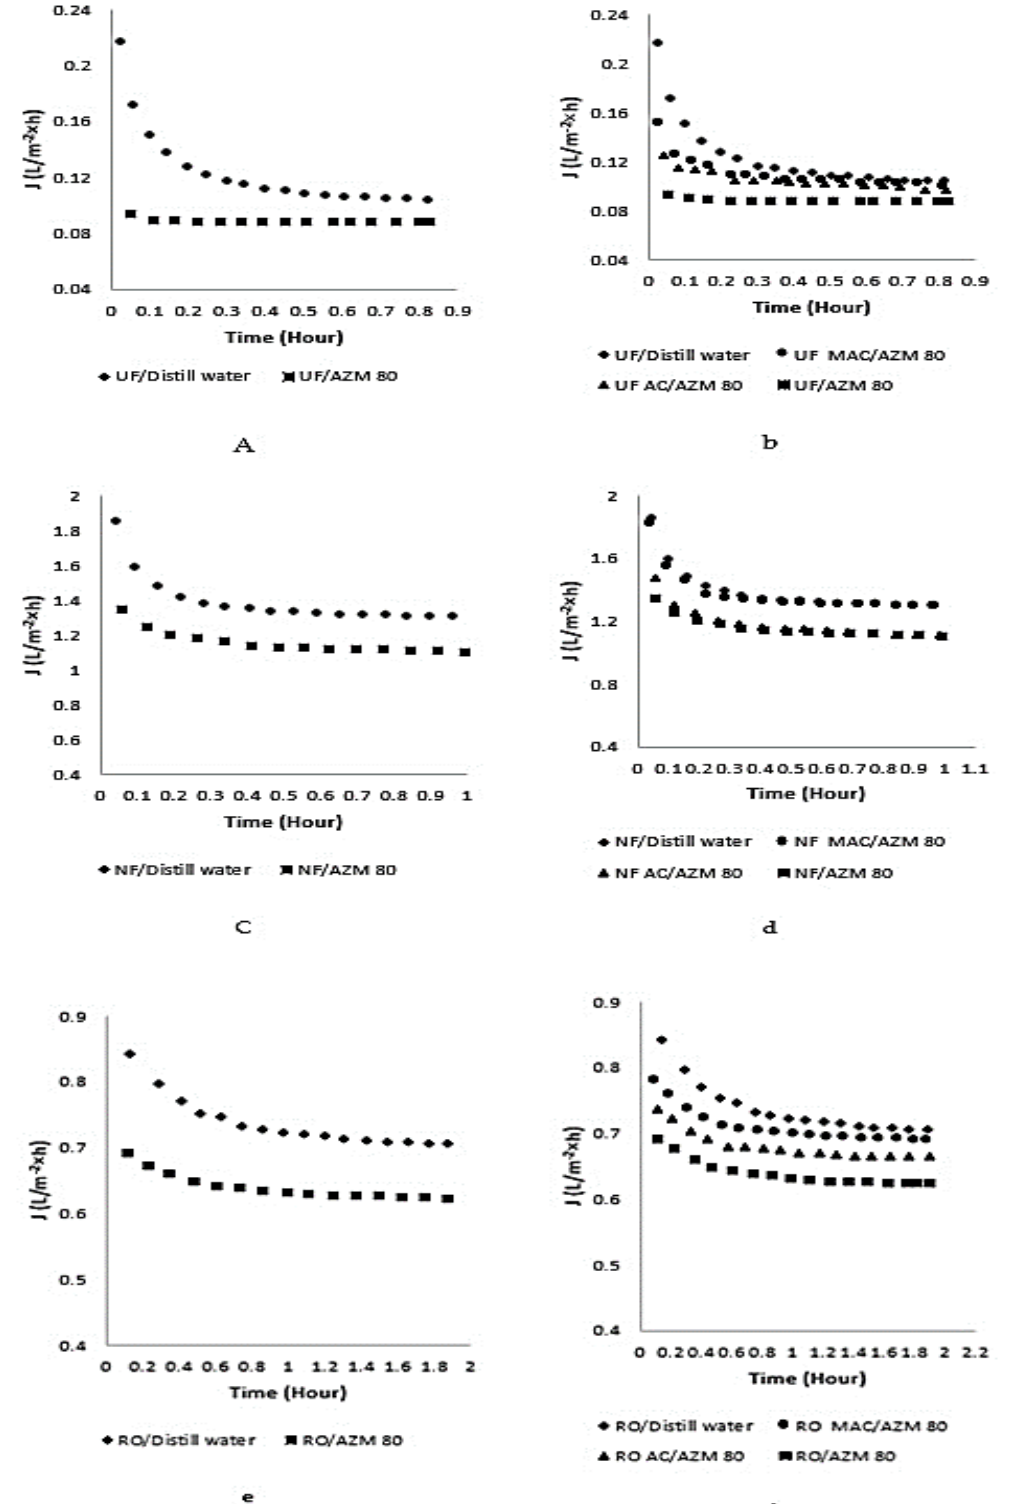
Figure 11. Effect of AZM on permeates flux and improvement brought about by AC and MAC ( a ) UF membrane alone ( b ) AC/UF, MAC/UF ( c ) NF membrane alone ( d ) AC/NF, MAC/NF ( e ) RO membrane alone ( f ) AC/RO, MAC/RO.